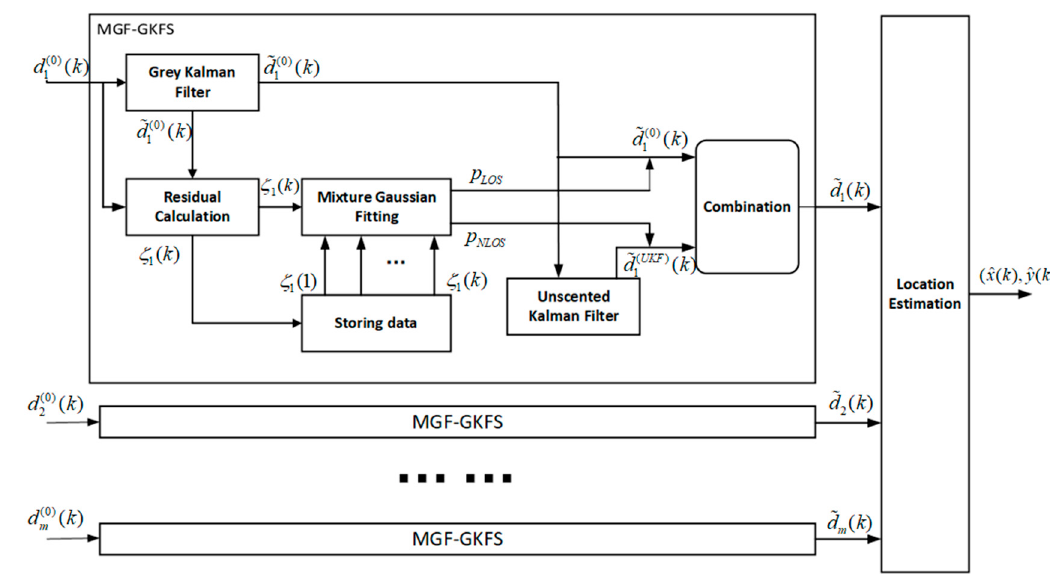
Figure 1. The flowchart of the proposed method.